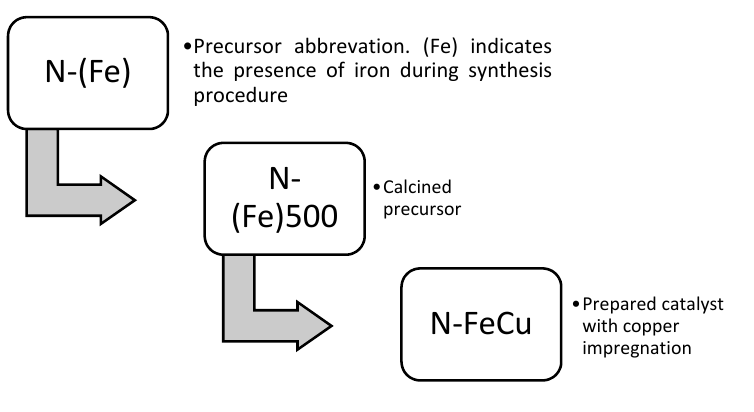
Figure 16. Sample nomenclature.